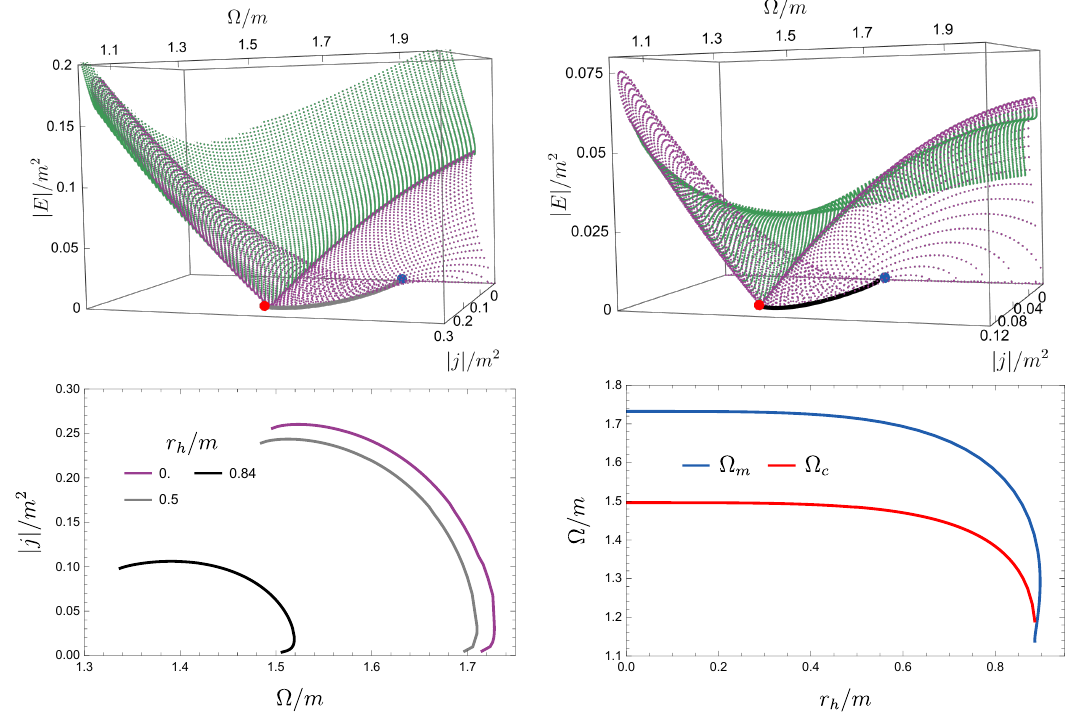
Figure 6 . Top : 3D development of the lobed curves in figure 3 in the vicinity of the first critical point, with an extra Ω axis, for r h /m = 0 . 5 (left) and r h /m = 0 . 84 (right). Magenta (green) surfaces belong to the Minkowski (BH) phase. Beware the difference in vertical scales. The purple or blue dots are Minkowski embeddings and the green or red ones BH embeddings. The gray thick lines represent the | E | = 0 vector meson Floquet condensates. Lower left : vertical view of the upper left plot where the gray lines in the upper left plot have been graphed for three different temperatures. Lower right : movement of the two extreme points in the curve as a function of r h . They are the critical embedding and the first meson mass frequency respectively. We see that the effect of the background temperature is mild (less than 10%) until the value r h /m ∼ 0 . 8 is